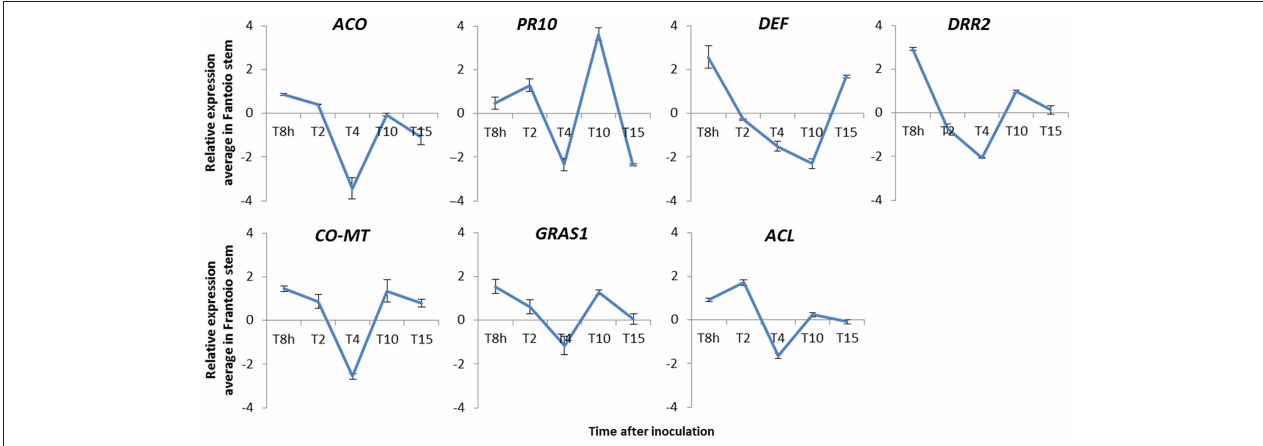
FIGURE 2 | Relative expression (RE) average of seven genes identified in FD and/or FU cDNA libraries from aerial tissues of “Frantoio” olive plants at different time points after Verticillium dahliae inoculation in roots. ACO , 1-aminocyclopropane-1-carboxylate oxidase; DRR2, disease resistant response protein; ACL , acetone cyanohydrin lyase; GRAS1, transcription factor GRAS1; CO-MT, caffeoyl-o-methyltransferase; PR10, pathogenesis-related protein 10; and DEF , defensin protein 1. Error bars represent the SD from at least two independent qRT-PCR experiments. RE values (log2-fold-change values) were calculated according to the 2 − 11 Ct method ( Livak and Schmittgen,